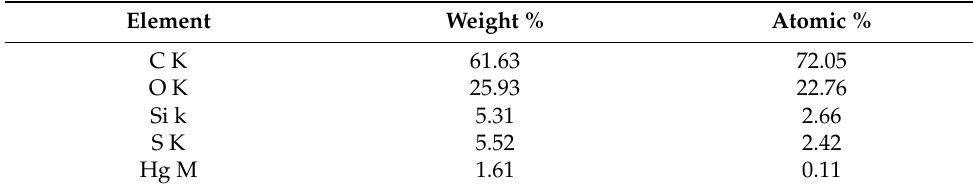
Figure 4. SEM images of ( a ) CF before modification, ( b ) CF-SH-Hg, ( c ) color intensity of CF-SH-Hg, and ( d ) EDX spectra of CF-SH-Hg. Table 1. Elements analysis of